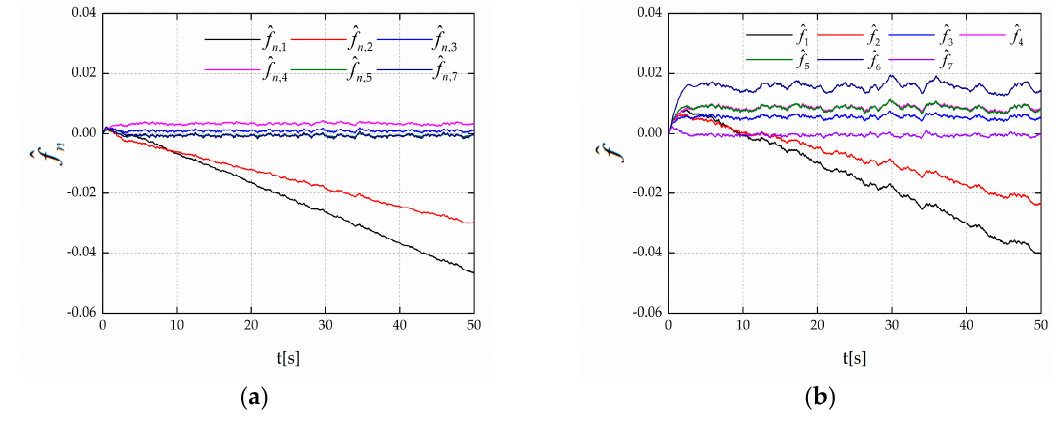
ˆ f ; ( b ) n ˆ f ; ( b ) ; n n